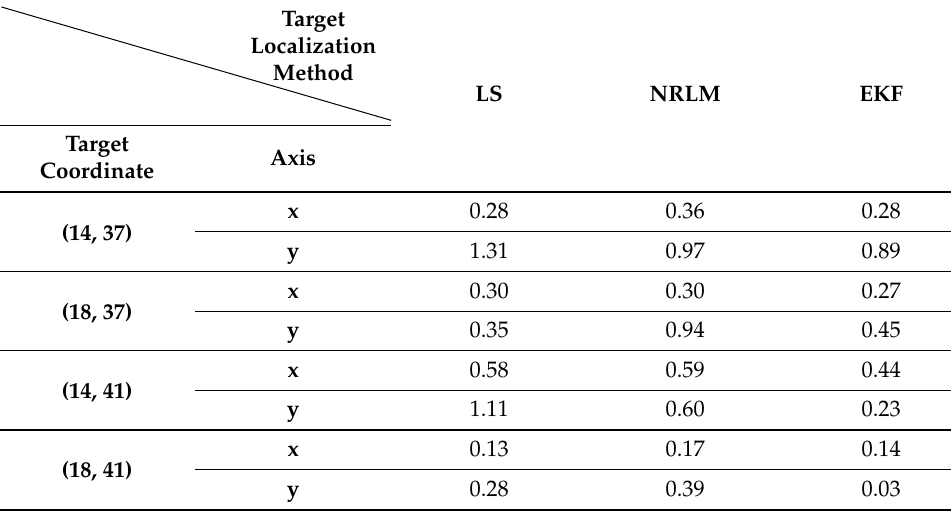
Table 2. Case 2—RMSE of target coordinates ( X, Y ) for human index finger (unit: